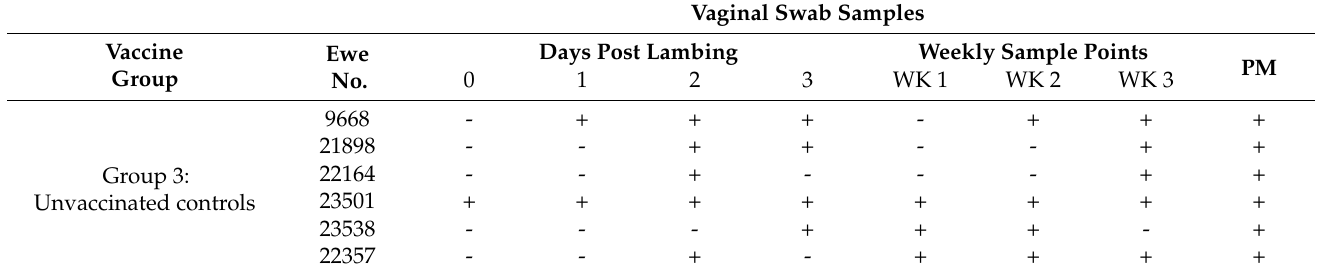
Vaginal Swab Samples